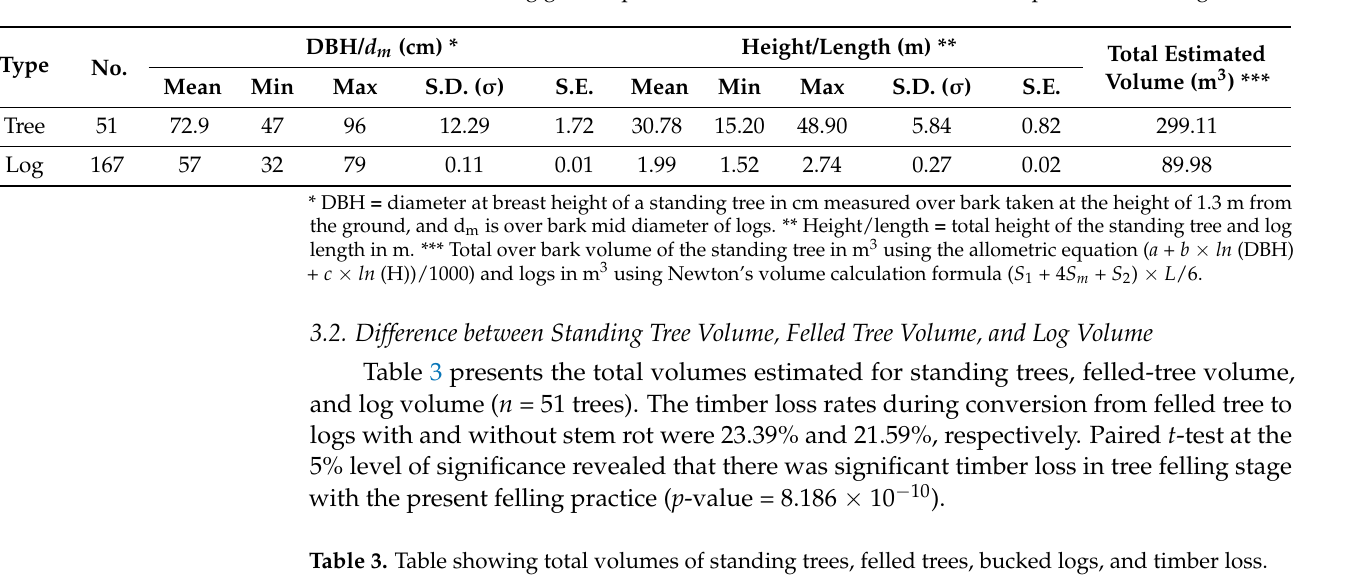
Table 2. Table showing growth parameters and estimated volume of sampled trees and logs.